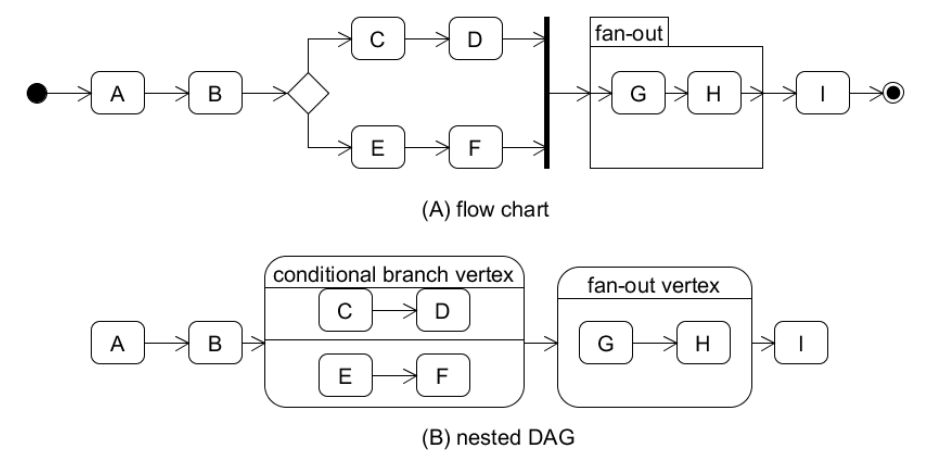
Figure 3. Example to show the nested and directed acyclic graph representation. A fan-out or a conditional branch has its sub-workflow, and its sub-workflow is inside of the vertex representing it. Hence, the overall workflow graph is linear, has only one source vertex, and one sink